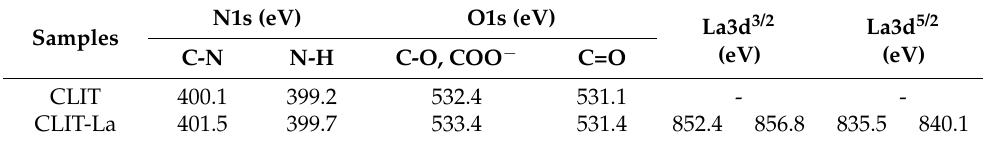
Figure 3. XPS curves of CLIT and CLIT-La. Table 1. XPS binding energy of CLIT and